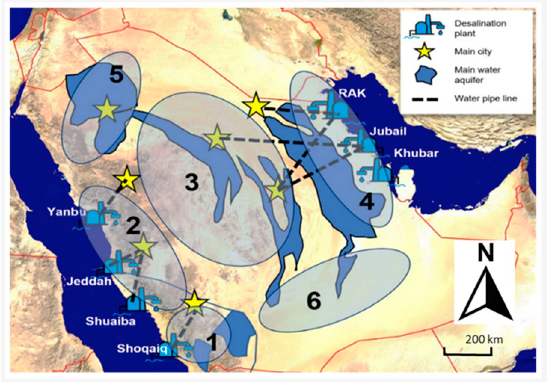
Figure 13. Water resources and main demand zones in Saudi Arabia [21].